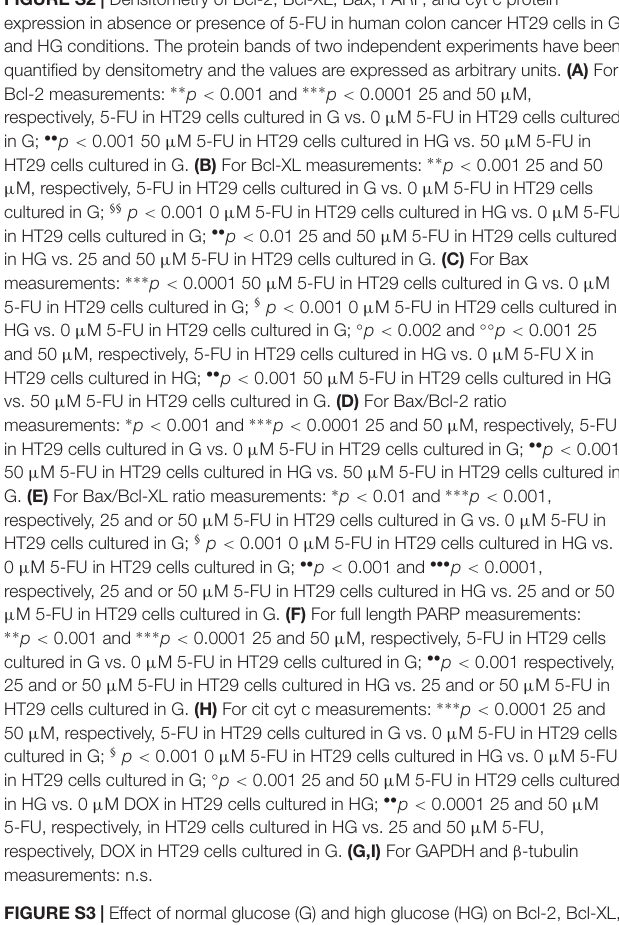
FIGURE S3 | Effect of normal glucose (G) and high glucose (HG) on Bcl-2, Bcl-XL, Bax, PARP, and cyt c protein expression in absence or presence of 5-FU (5-FU) in human colon cancer LOVO cells. Cells were cultured for ≥ 7 days in the presence of G and HG, incubated for 24 h before analysis with 25 and 50 µ M 5-FU, then washed and lysed. The level of GAPDH, used as an housekeeping protein in total lysates, and the level of β -tubulin, used as an housekeeping protein in mitochondrial lysates, were used to check the equal protein loading. The figure is representative of three independent experiments. FIGURE S4 | Densitometry of Bcl-2, Bcl-XL, Bax, PARP, and cyt c protein expression in absence or presence of 5-FU in human colon cancer LOVO cells in G and HG conditions. The protein bands of two independent experiments have been quantified by densitometry and the values are expressed as arbitrary units. (A) For Bcl-2 measurements: ∗ p < 0.01 25 and 50 µ M, respectively, 5-FU in HT29 cells cultured in G vs. 0 µ M DOX in HT29 cells cultured in G; •• p < 0.001